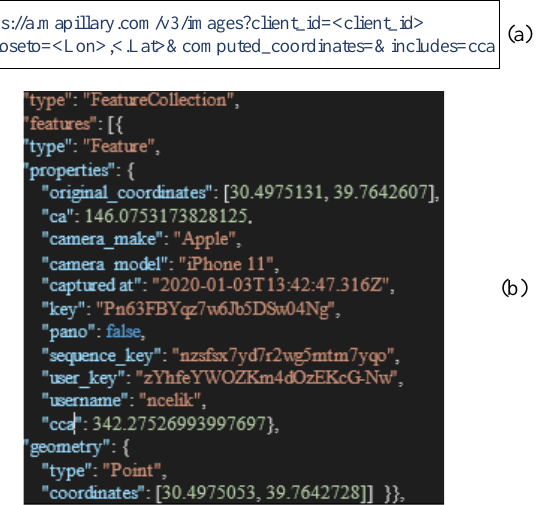
Figure 1. A query URL for Mapillary API (a) and downloaded JSON format response from Mapillary of one of the image (b)